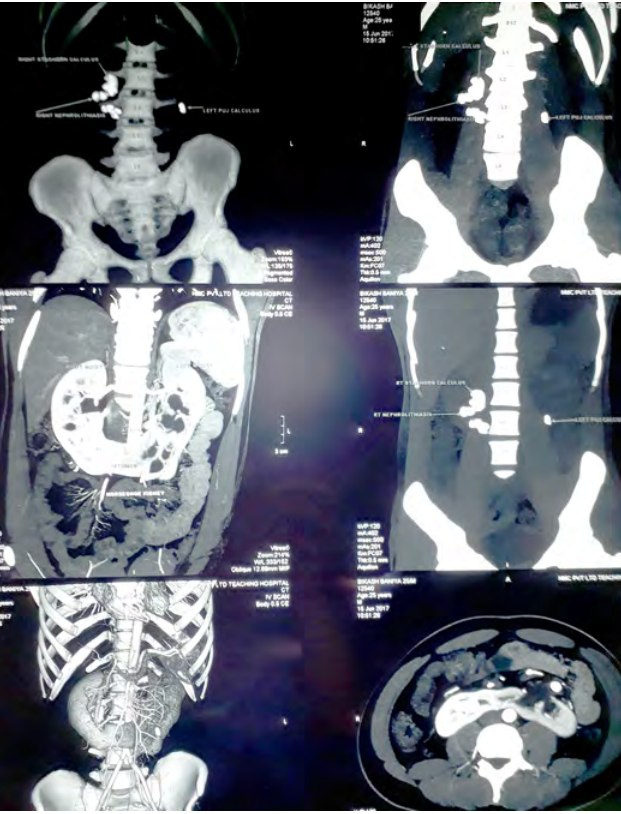
Fig 1: CT urography of a patient with horseshoe kidney with bilateral renal